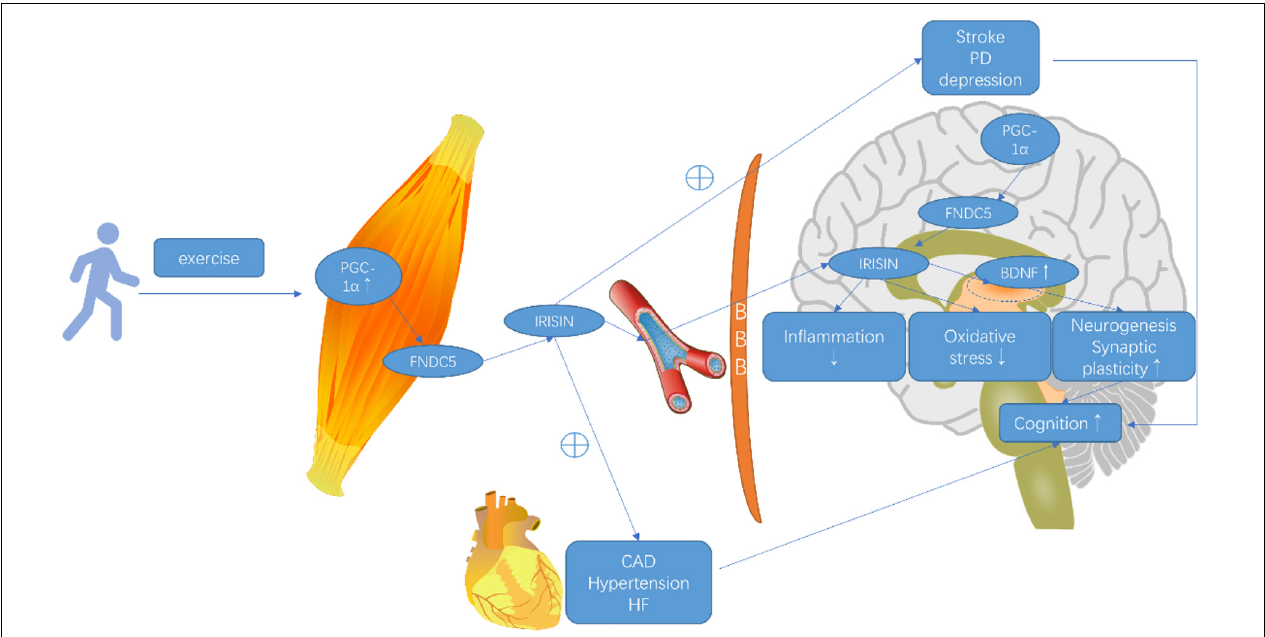
FIGURE 1 | Effects of FNDC5/irisin on elderly dementia and cognition. Exercise promoted PGC-1 α , which stimulated fibronectin type III domain-containing protein 5 (FNDC5) to be dissected into irisin. Irisin was shed into a blood vessel, circulating the whole body and passing through blood–brain barrier. Irisin might increase the expression of brain-derived neurotrophic factors, which improved synaptic plasticity, neuronal survival, neuronal differentiation, and neuronal health, thus cognition. FNDC5 was also highly expressed in hippocampus and stimulated by peroxisome proliferator-activated receptor γ (PPAR γ ) coactivator-1 α (PGC-1 α ) to be cleaved into irisin. Besides, irisin acts with its anti-inflammation and anti-oxidative effects to defend cognition deficits. Furthermore, FNDC5/irisin might have positive connections to dementia-related diseases, such as coronary artery disease, hypertension, heart failure, stroke, and Parkinson’s disease, and depression to protect against